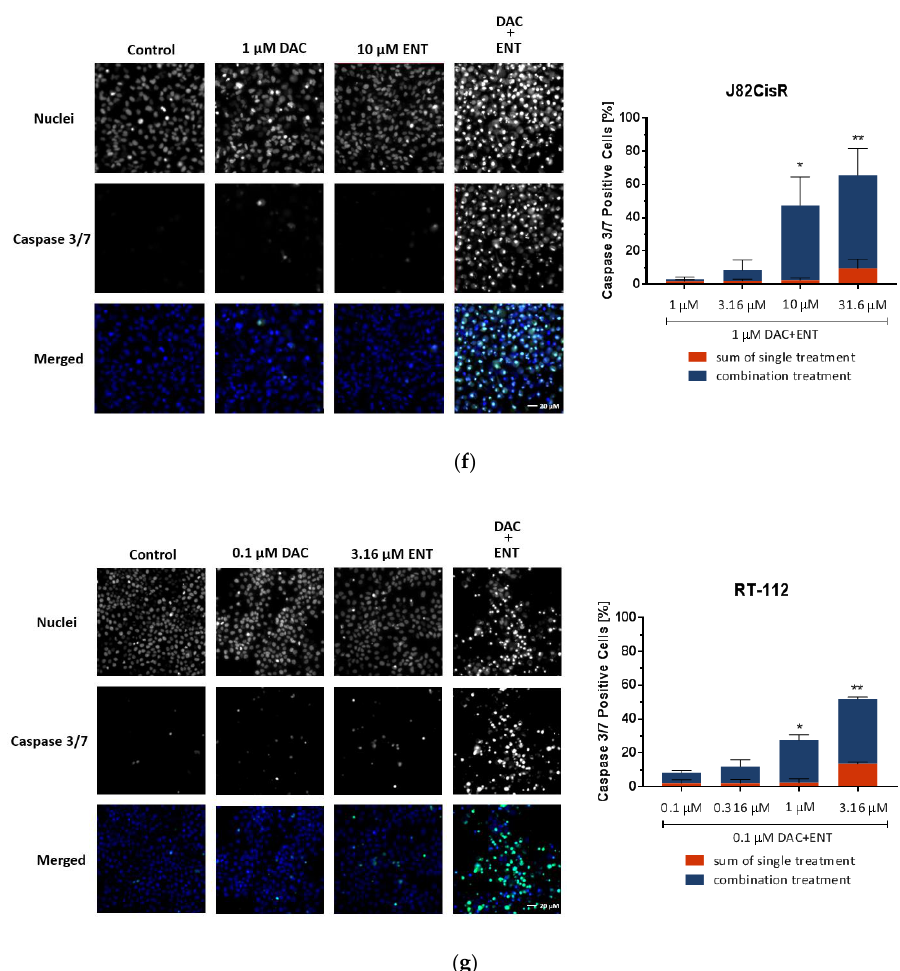
Figure 3. DAC and ENT acted synergistically to induce caspase 3/7-mediated apoptosis. ( a – c ) Combinations of DAC (1 µM in J82 and J82CisR, 0.1 µM in RT-112) and ENT (3.16 µM in J82 and J82CisR, 2 µM in RT-112) led to increased sub-G1 fractions, compared with either agent alone in J82, J82CisR, and RT-112 cell lines. In each single experiment, 12,000 cells per condition were analyzed. Medium was used as control. Data shown are the mean ± SD of at least three independent experiments. ** p < 0.01, * p < 0.05 by t -test. ( d ) The sums of sub-G1 signals of single treatments are shown in red bars. The differences between the combination treatment effects and the sums of single treatment effects are shown in extended blue bars (superadditive (=synergistic) part). Data shown are the mean ± SD of at least three independent experiments. ** p < 0.01, * p < 0.05 by t -test. ( e – g ) The 48 h treatment of DAC followed by 48 h ENT leads to caspase 3/7 activation in a synergistic manner in J82, J82CisR, and RT-112 cells. A minimum of 500 cells per condition were analyzed in each single experiment. Medium was used as control for untreated cells, and cisplatin (not shown) was used as positive control for caspase 3/7 activation. Cells were stained with Hoechst 33342 (blue) for cell nuclei and CellEvent Caspase-3/7 green detection reagent for the activation of caspase 3/7. Quantification of caspase 3/7 positive cells is displayed in the right panel. The sums of percentages of caspase 3/7 positive cells of single treatment are shown in red bars. The differences between the combination treatment effects and the sums of single treatment effects are shown in extended blue bars (superadditive ( = synergistic) part). Data shown are the mean ± SD of at least three independent experiments. *** p < 0.001, ** p < 0.01, * p < 0.05 by t -test. Scale bars for ( e – g ): 20 µ